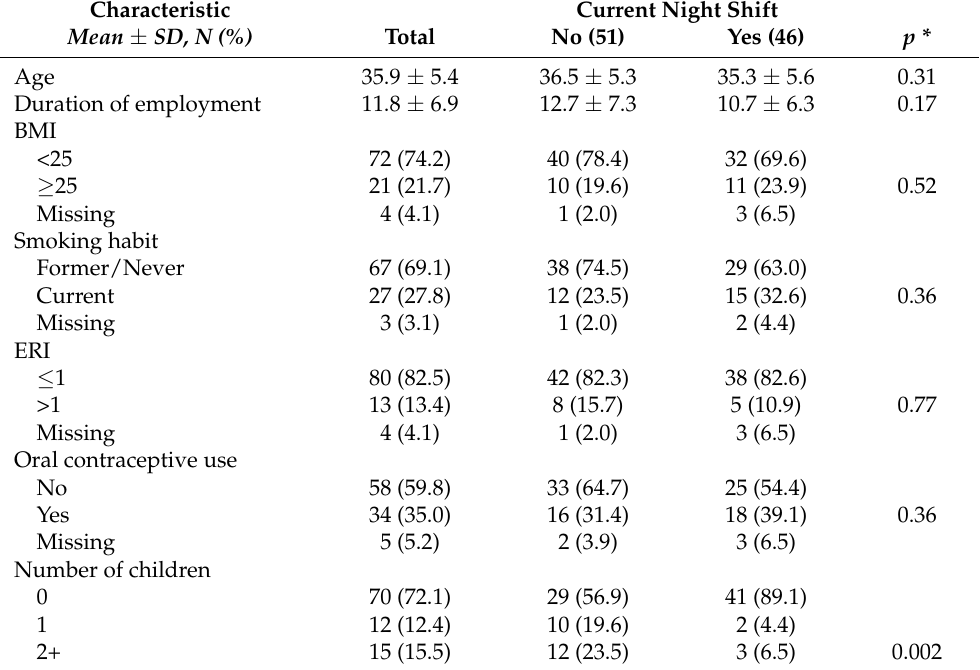
Table 1. Characteristics of the study